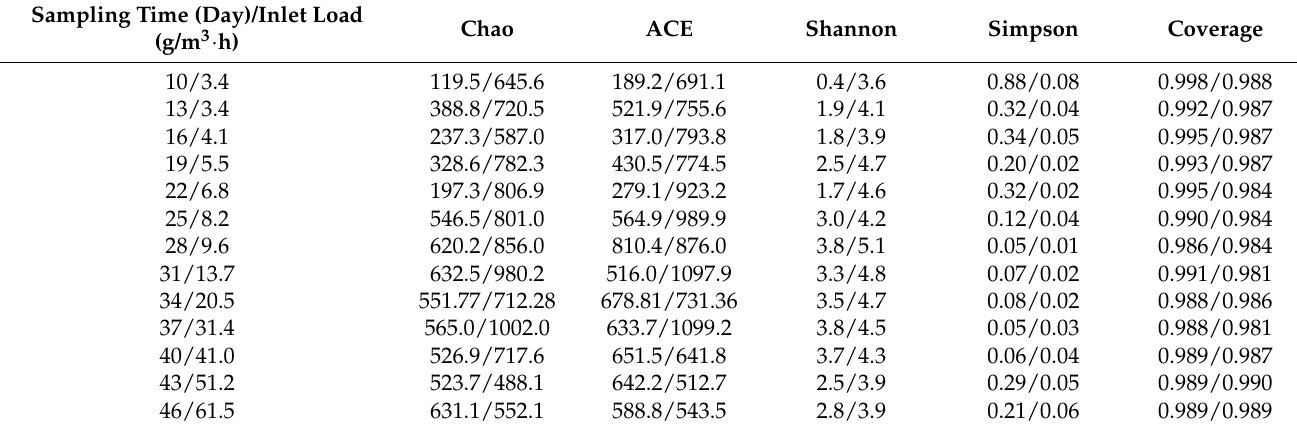
Table 4. Statistical table of Alpha diversity indices, each index consists of composite filler BTF/bark filler